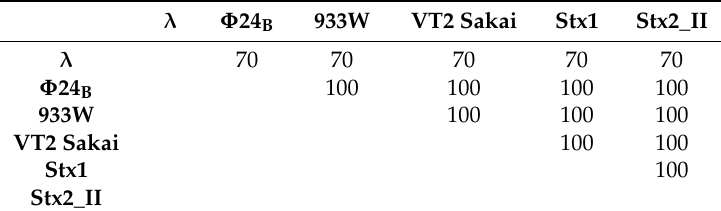
Table 5. Scores of pairwise alignments of the predicted amino acid sequences of Orf61 from six